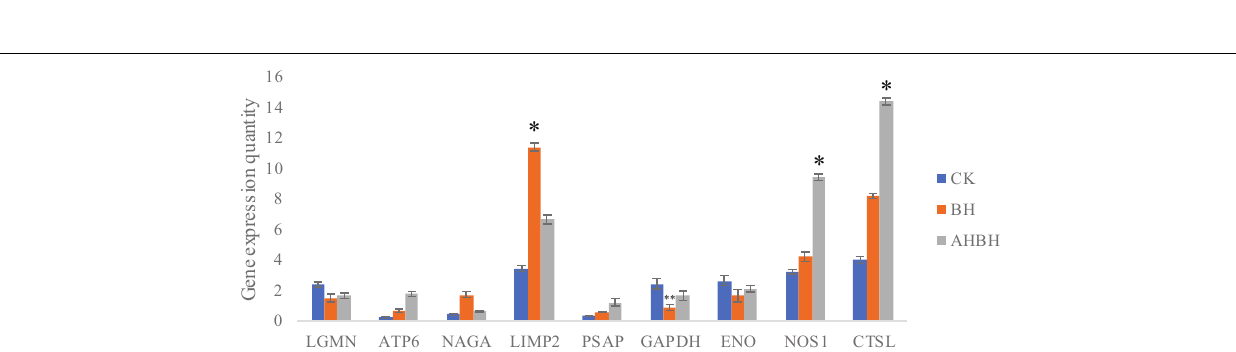
FIGURE 6 | KEGG metabolic pathways based on transcriptome gene expression in gill tissues of C. japonica . Red, up-regulated genes; green, down-regulated genes; CK, control group; BH, C. japonica immersed in berberine hydrochloride; BHAH1, C. japonica immersed in berberine hydrochloride and injected with A. hydrophila .